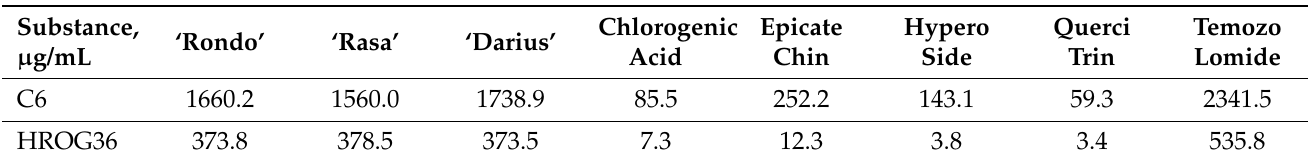
Table 3. Calculated EC 50 of extracts from leaves of quince cultivars ‘Rondo’, ‘Rasa’, and ‘Darius’ and of some phenolic compounds found in the extracts for C6 and HROG36 cells.